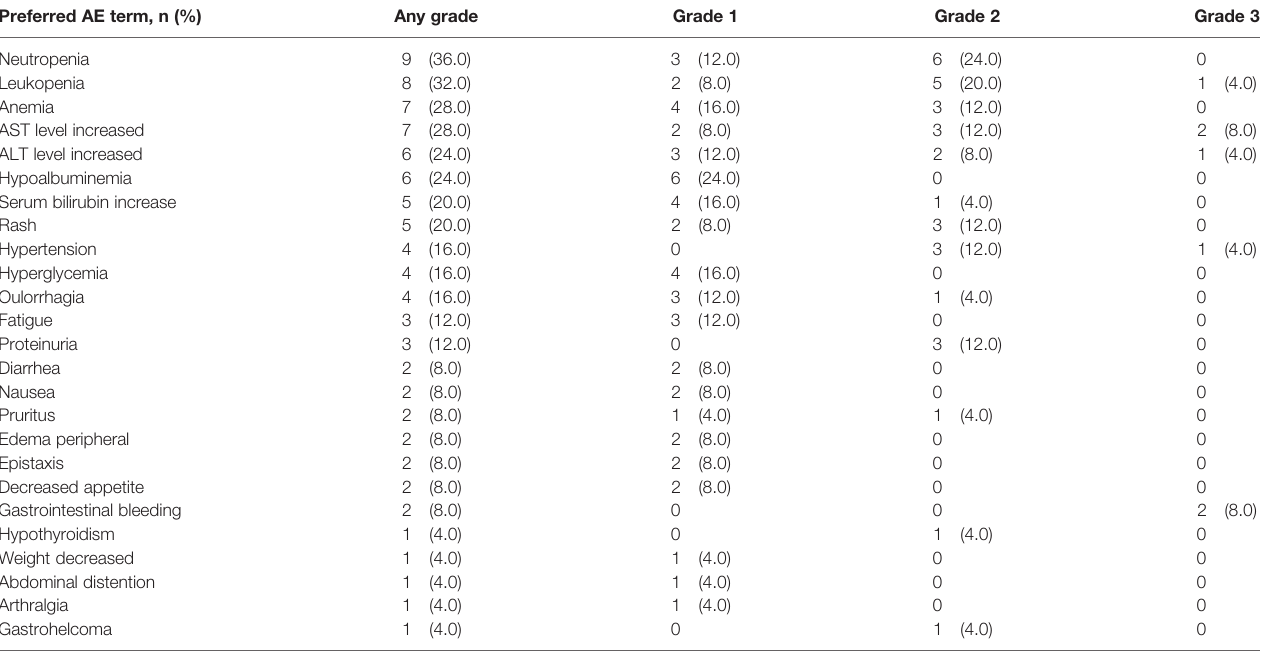
TABLE 2 | Summary of the most common treatment-related adverse events in patients with advanced hepatocellular carcinoma receiving triple therapy (n = 25). Preferred AE term, n (%) Any grade